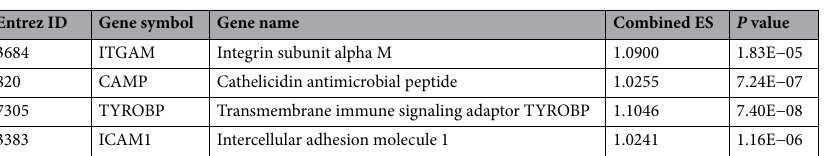
Table 1. Four upregulated DEGs ( ITGAM , CAMP , TYROBP and ICAM1 ) in CAD relative to normal subjects.